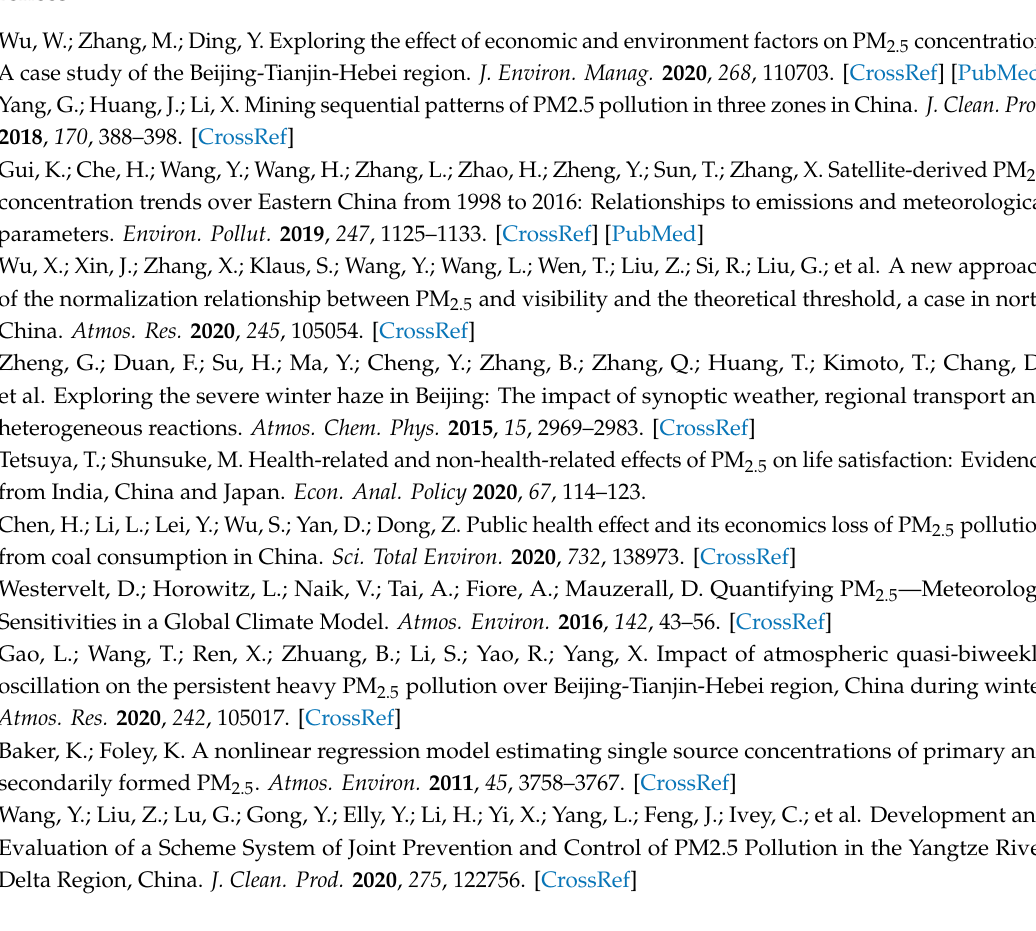
Table S1. Daily proportion of OM, NH 4 + , SO 42 − , NO 3 − , EC and other component (Ot) in PM2.5. Table S2.